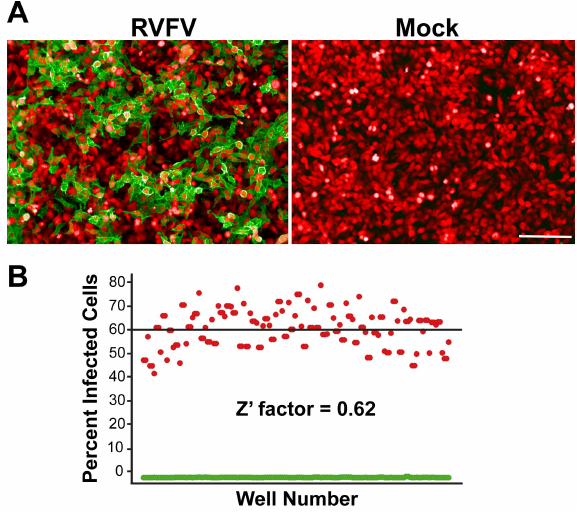
Figure 2. Primary screening of protease inhibitor library. Scatter plot of primary screening data where the percentage of infected cells was normalized with mock-treated, RVFV-infected cells to determine the percentage of infection inhibition. A collection of 849 compounds from the ChemDiv protease inhibitor library in 13 96-well plates were screened at a 20 m M concentration against RVFV MP12 strain in HeLa cells. Data from each of the 13 plates are represented by same color. Hit compounds having greater than 50% antiviral activity (represented by horizontal black line) were selected for secondary screening.